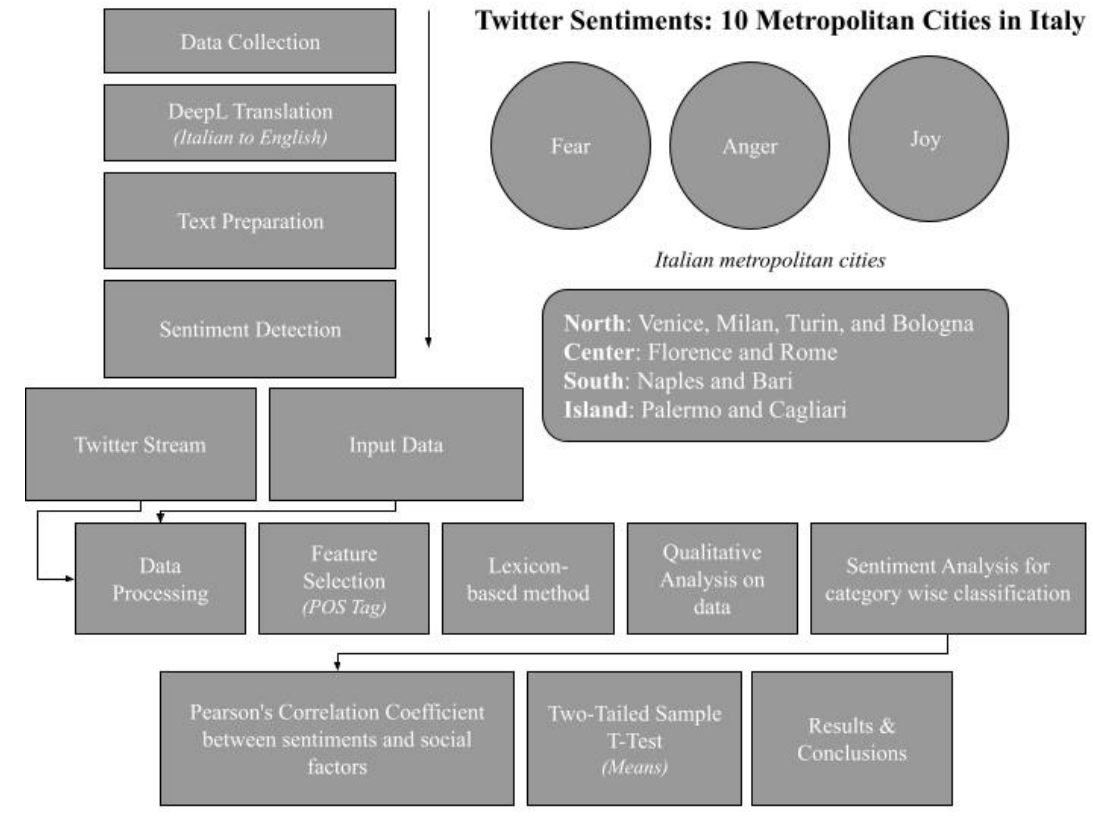
Figure 1. Research work flow model.